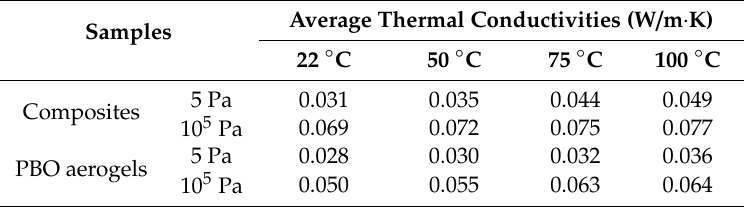
Figure 4. Thermal conductivities of the composites ( a ) and PBO aerogel ( b ) at 5 and 10 5 Pa under the different temperatures of 22, 50, 75 and 100 °C ( c ). Photos of PBO aerogel composites during the LOI test. Table 1. Thermal conductivities for composites and PBO